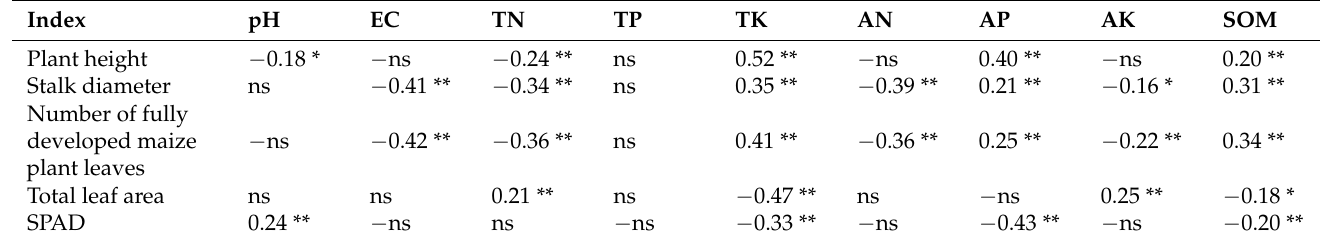
Table 3. Correlation analysis between maize growth and soil